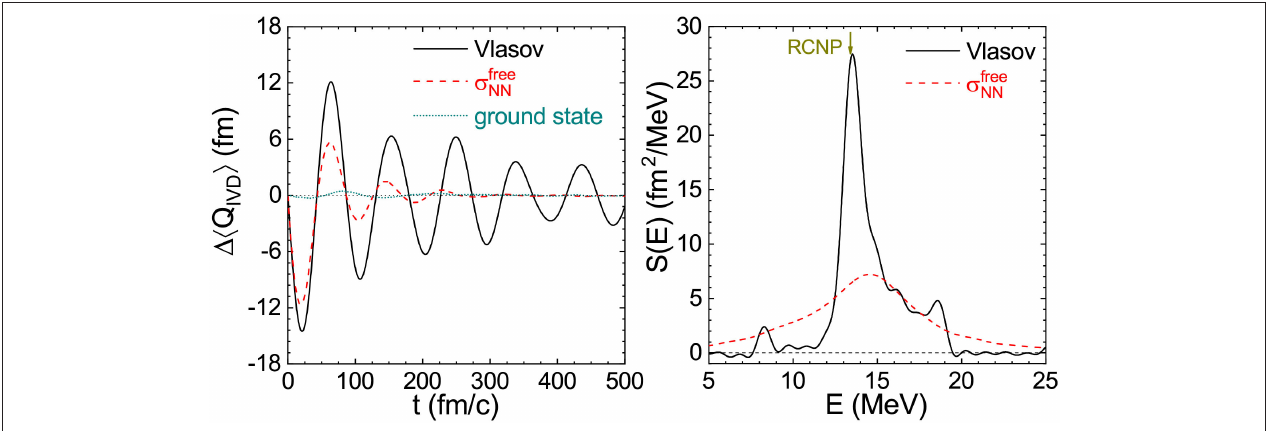
t 0 ) with λ λ ˆ Q IVD δ ( t 15 MeV / c obtained from the = − =